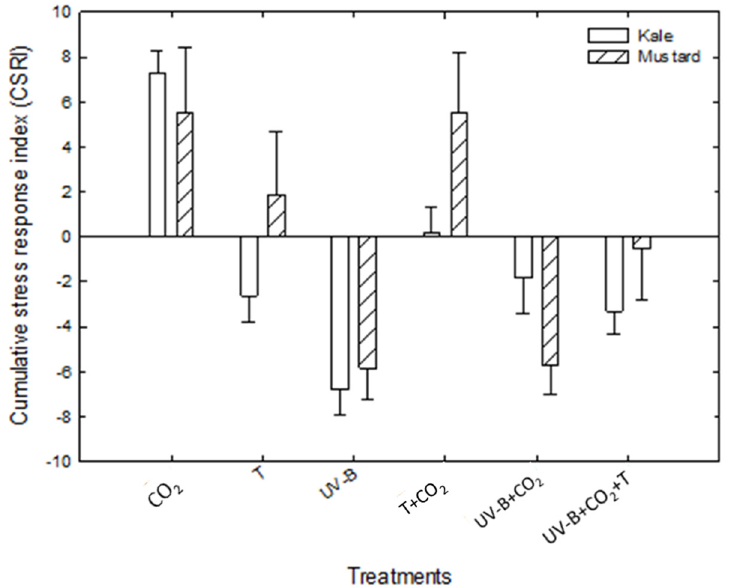
Figure 4. Cumulative stress response index (CSRI) calculated over all the treatments of kale and mustard in response to elevated carbon dioxide (720 ppm) (+CO 2 ), high temperature (35/27 °C, day/night) (+T), and increased UV-B radiation (10 kJ m − 2 d − 1 ) (+UV-B) and their interactions.